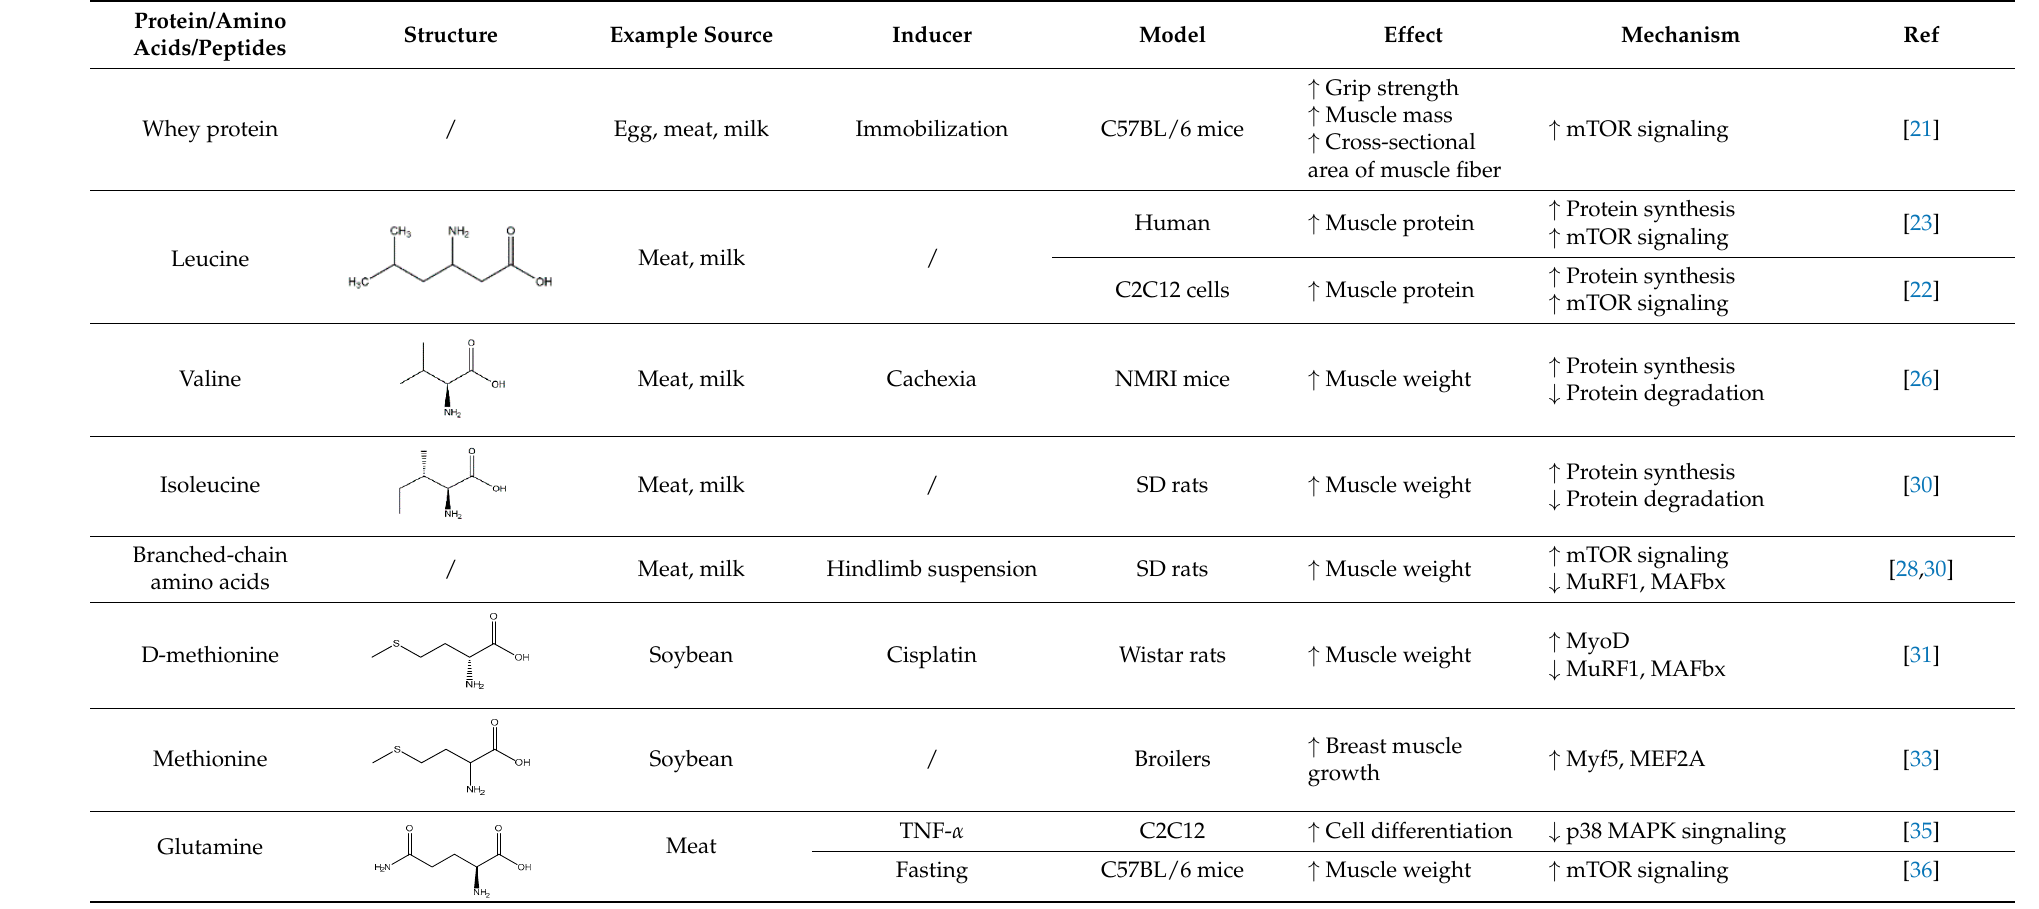
Table 1. Protein, amino acids, and peptides in the prevention of the muscle atrophy in vitro/vivo.